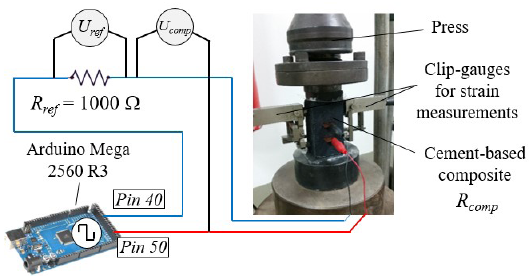
Figure 1. Experimental setup for evaluation of piezoresistive response of the